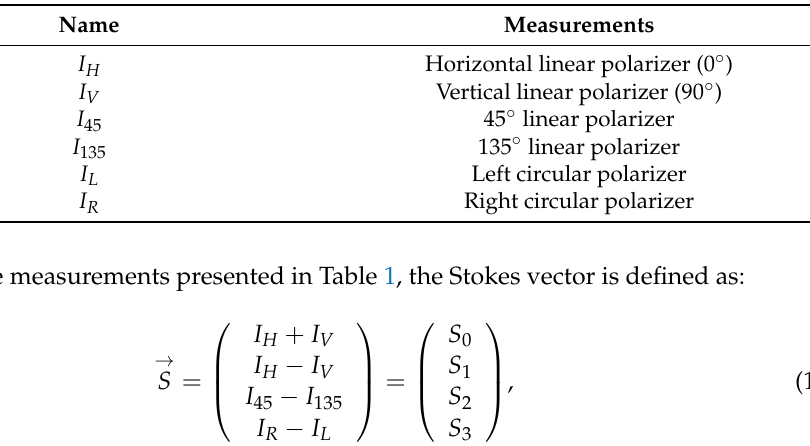
(cid:0) (cid:1) W/m 2 taken with ideal polarizers in front of a